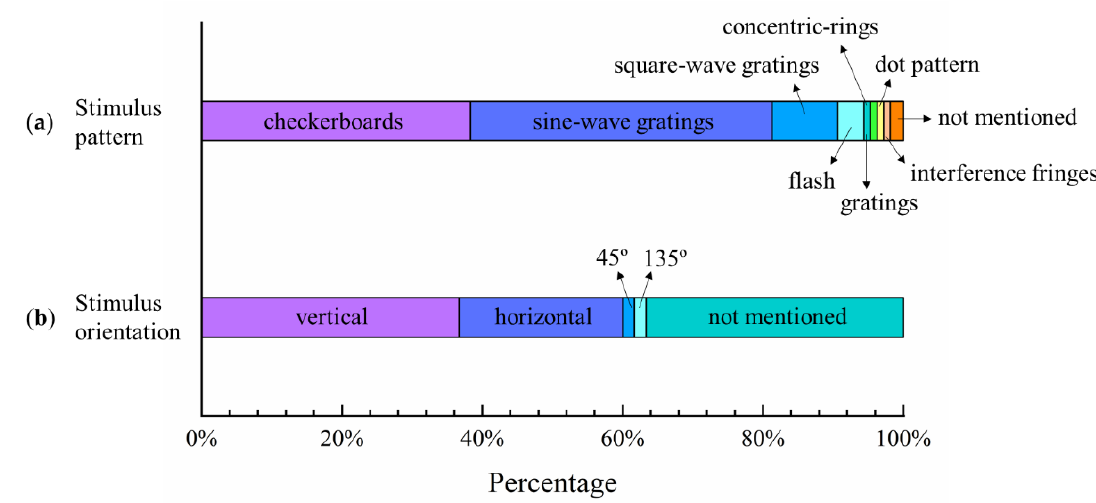
Figure 4. Percentages of ( a ) stimulus patterns and ( b ) grating orientations used in selected studies of VEP acuity assessment.